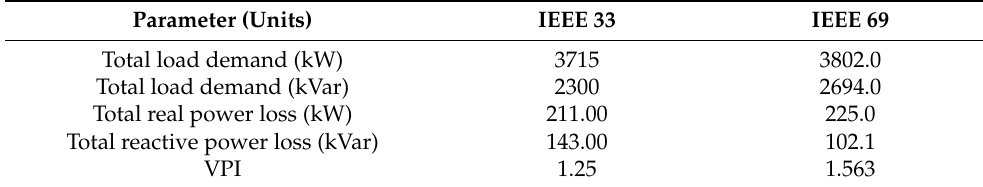
Table 3. Base Case Scenario